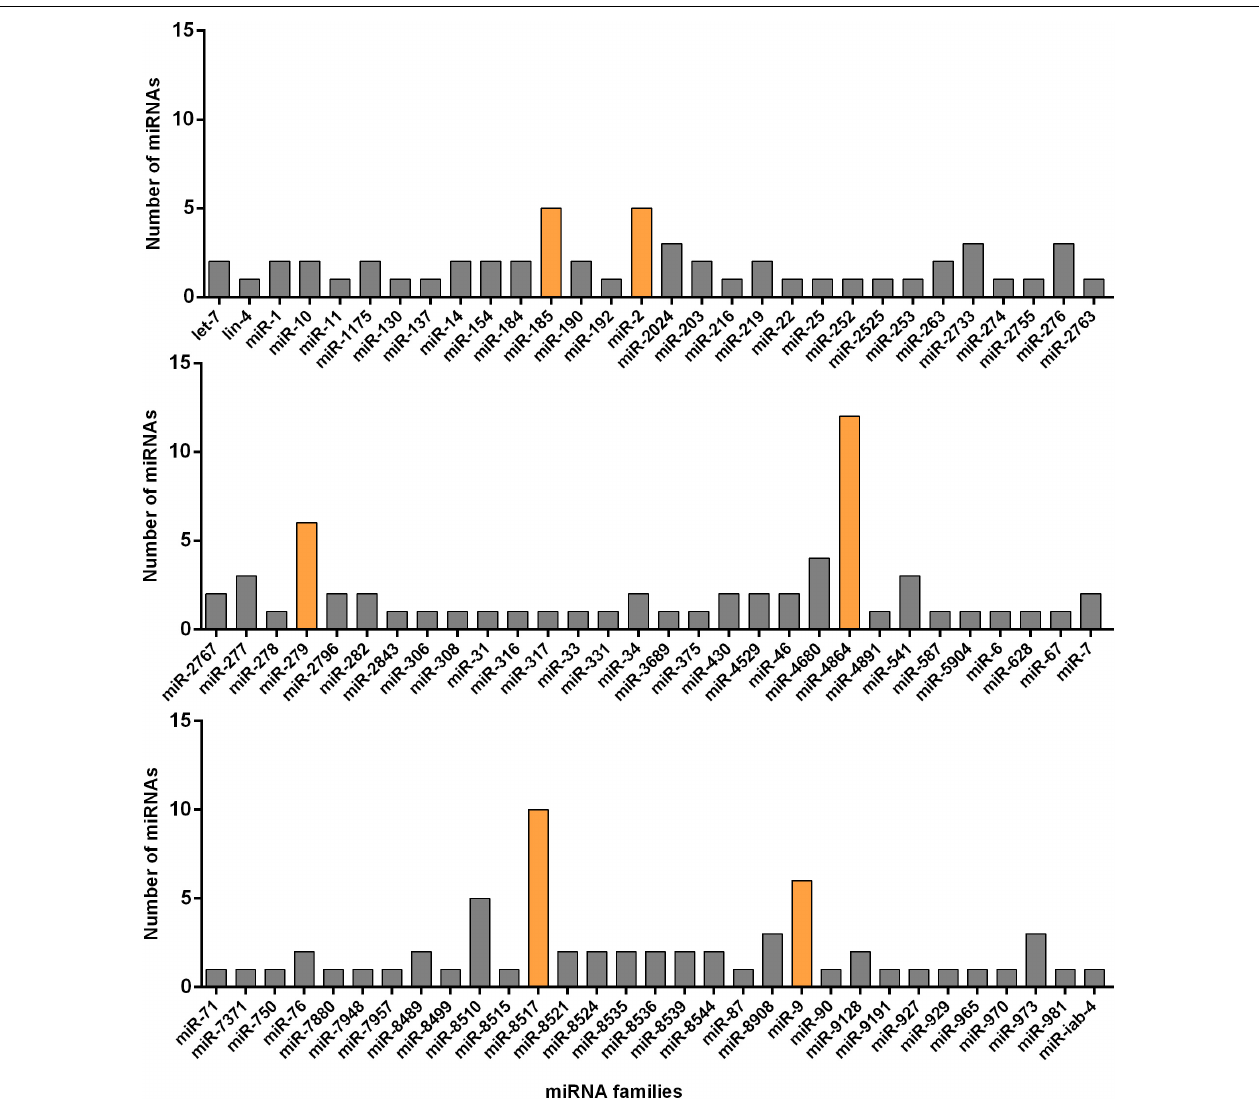
FIGURE 2 | Number of known miRNAs expressed in the resistant (Cry1S1000) and susceptible (G88) strains of DBM in each of the miRNA families. The families with relatively more members are marked with orange color while others with gray.